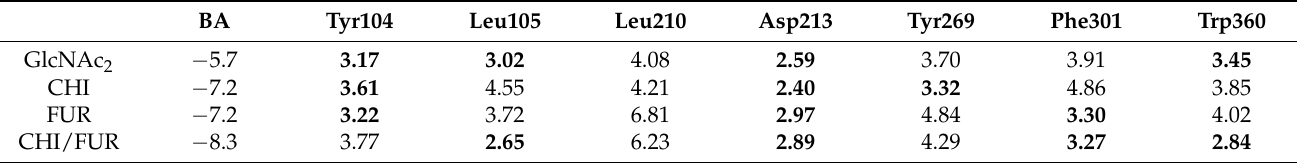
Table 3. Binding affinity (BA) in kcal · mol − 1 computed for CHI/FUR, CHI, FUR, and GlcNAc 2 bound to YKL-39 and key distances in Å between YKL-39 amino acids and ligands. Hydrogen bonds are marked in